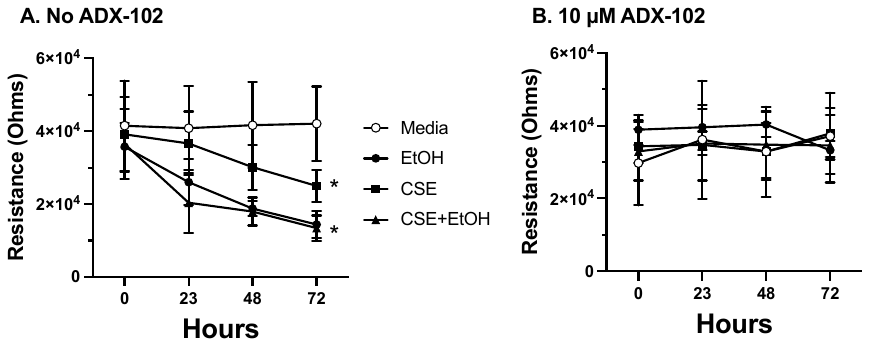
9 of 14 Figure 5. ADX-102 and loss of tracheal epithelial cell cilia. Ciliated MTECs were treated with a com- bination of 5% cigarette smoke extract (CSE) and 50 mM ethanol (EtOH) in the presence or absence of 10 µM ADX-102, and the average number of motile cilia were measured at 3 ( A ) and 24 h ( B ). **** p < 0.01 vs. medium control or presence of ADX. Bars represent SEM of at least n = 9 individual experiments. ns = not significant. 3.5. ADX-102 and Barrier Function Epithelial cell barrier function is negatively impacted by both cigarette smoke [23] and alcohol [24]. Resistance across a confluent monolayer of 16HBE cells was significantly